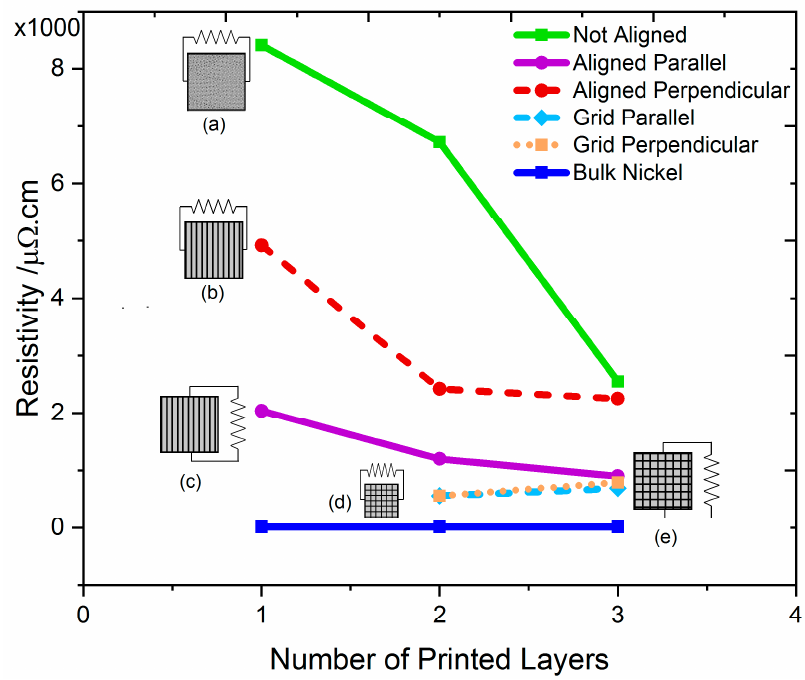
Figure 7. Electrical characterization of Ni for particles ( a ) not aligned, ( b , c ) aligned (nanowires), and ( d , e ) in grid orientation